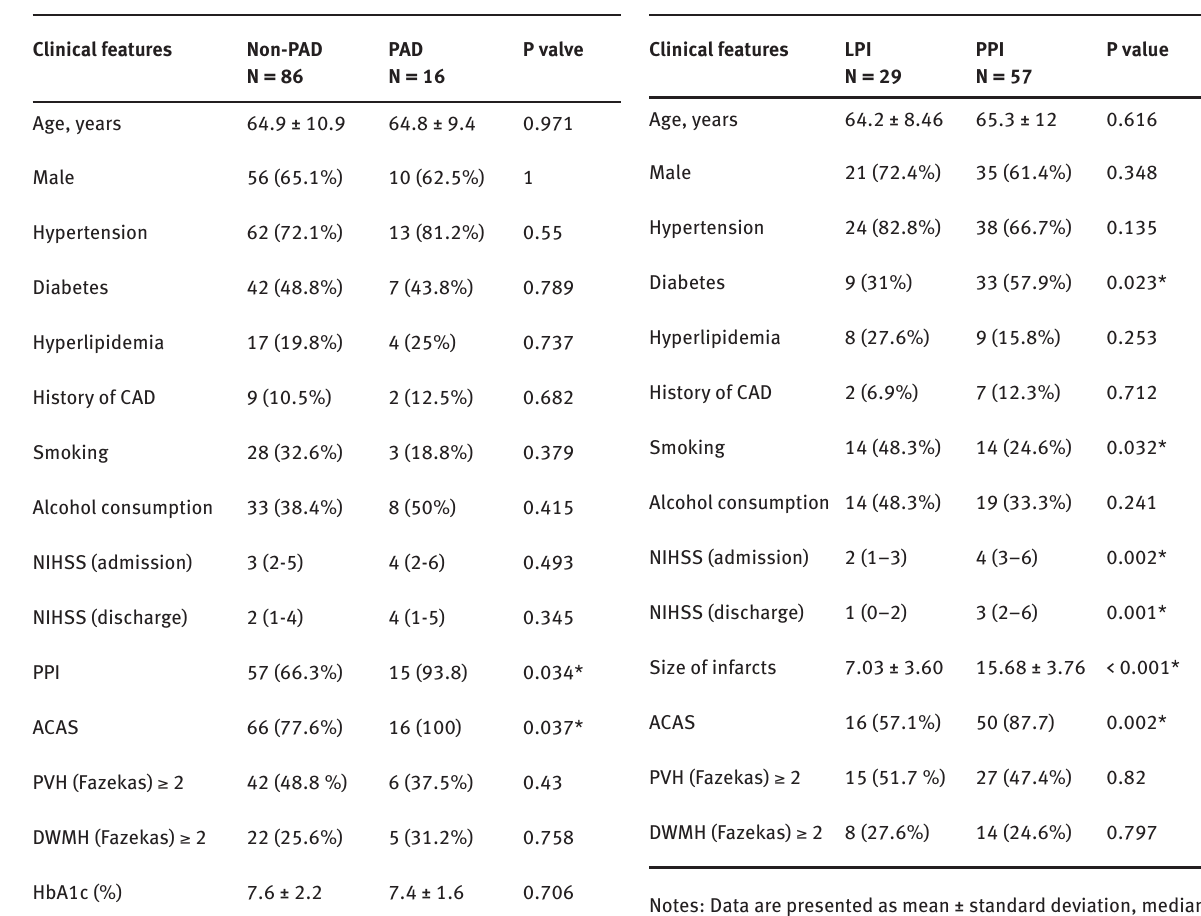
Table 2: Characteristics according to lesion type by DWI in patients with normal basilar